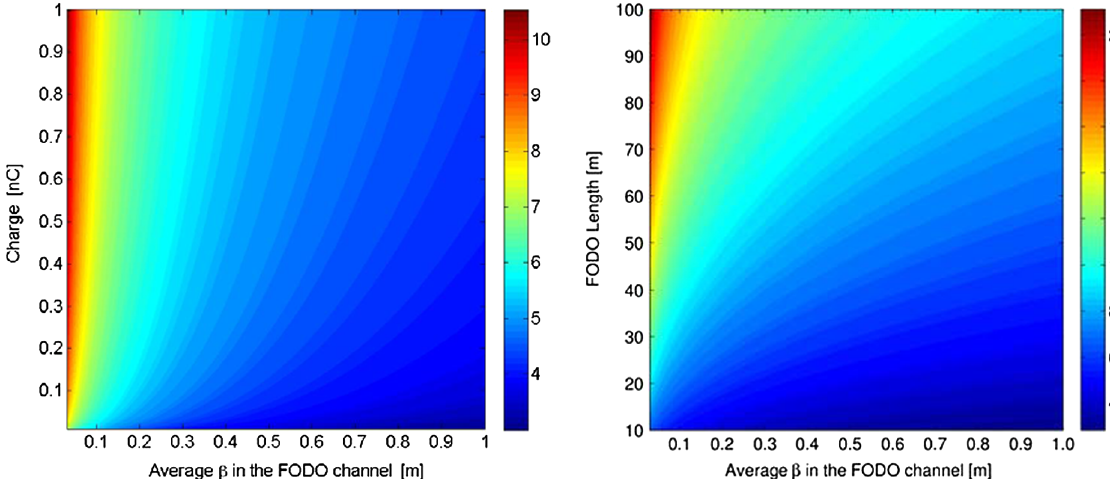
¯ β ; ¯ β ; Q Þ space for L ¼ 30 m (left), and in the ð L Þ space for Q ¼ 500 pC. Both